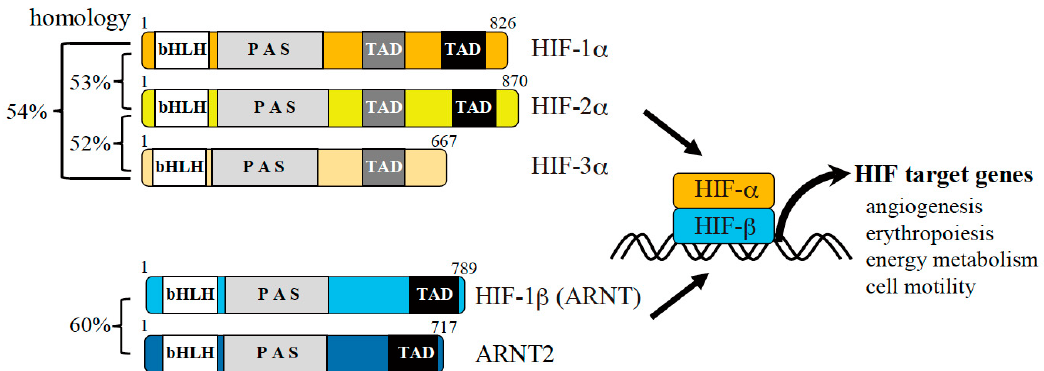
Figure 2. Hypoxic gene expression mediated by hypoxia-inducible factors (HIFs). There are three α and 32